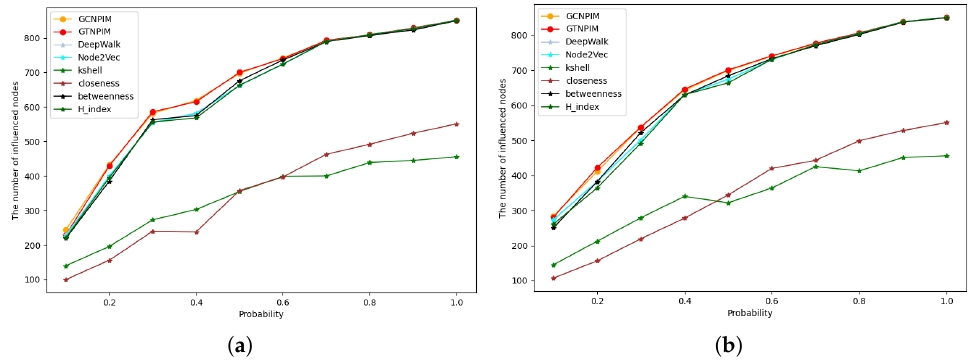
Figure 5. The spread of influence with different spreading probabilities for proposed model and baseline algorithms under the IC model. ( a ) Biological computing data, ( b ) Membrane computing